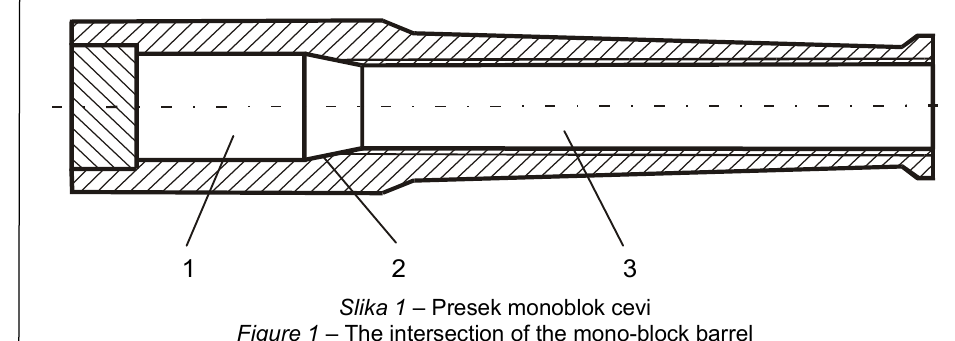
Figure 1 – The intersection of the mono-block